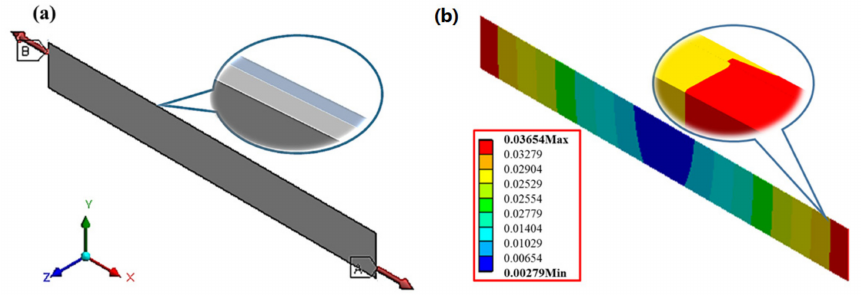
Figure 6. ( a ) The finite element model of uniaxial tension established in ANSYS 15.0; ( b ) the elongation diagram from FE numerical